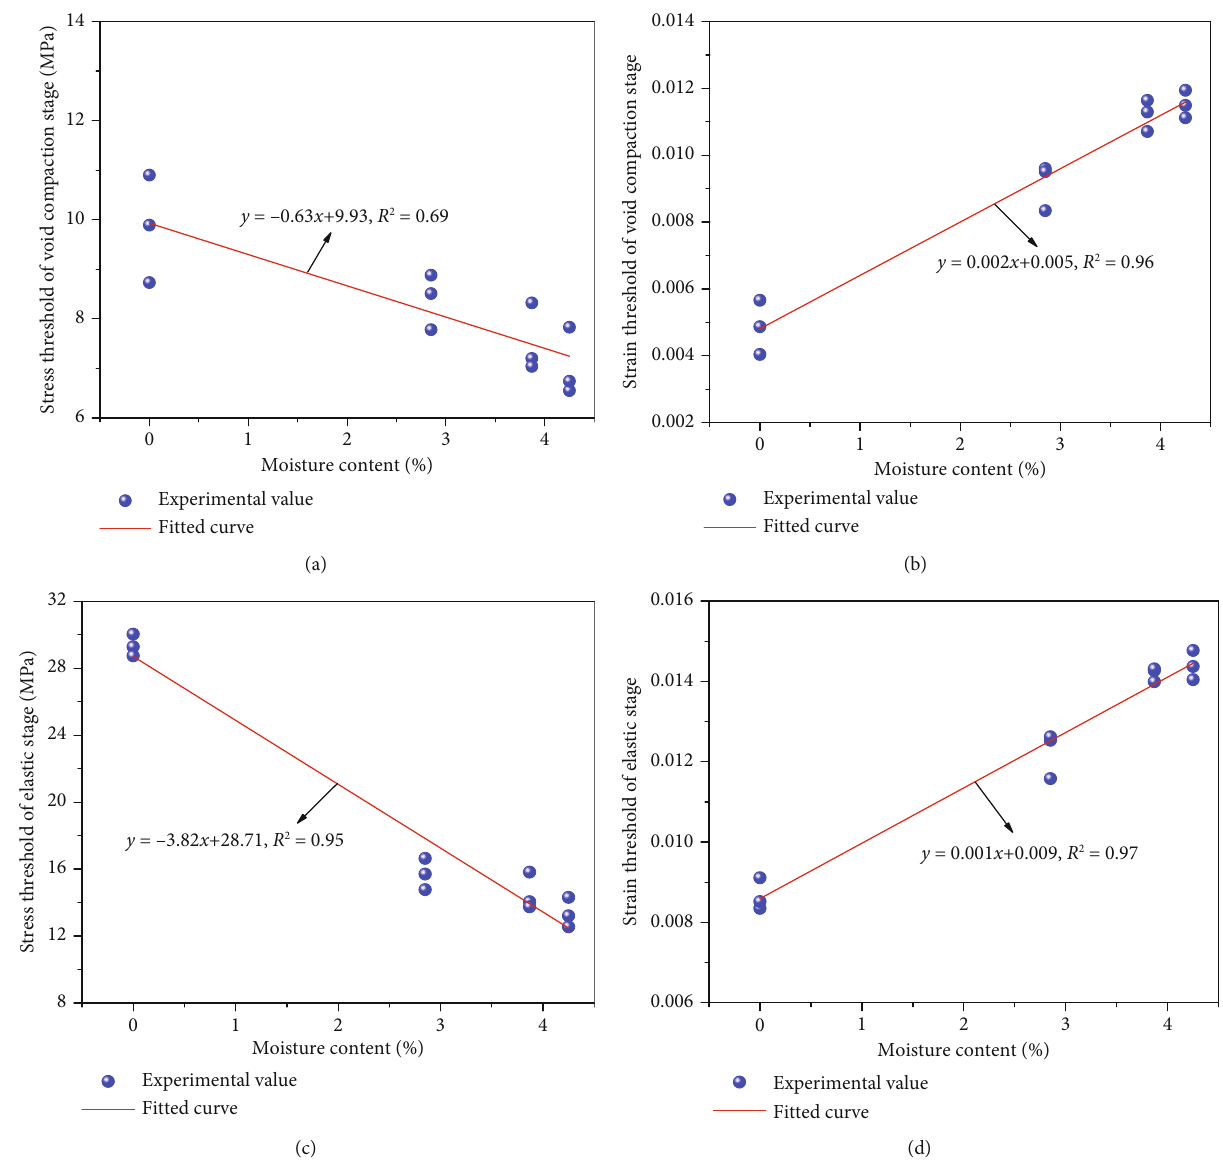
Figure 8: Relationship between threshold of void compaction stage and threshold of elastic stage and moisture content. (a) Stress threshold- moisture content curves of void compaction stage, (b) strain threshold-moisture content curves of void compaction stage, (c) strain threshold-moisture content curves of elastic stage, and (d) strain threshold-moisture content curves of elastic